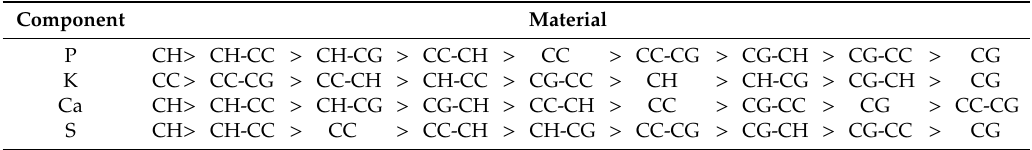
Table 2. Series of materials according to decreasing concentration of individual macroelements in